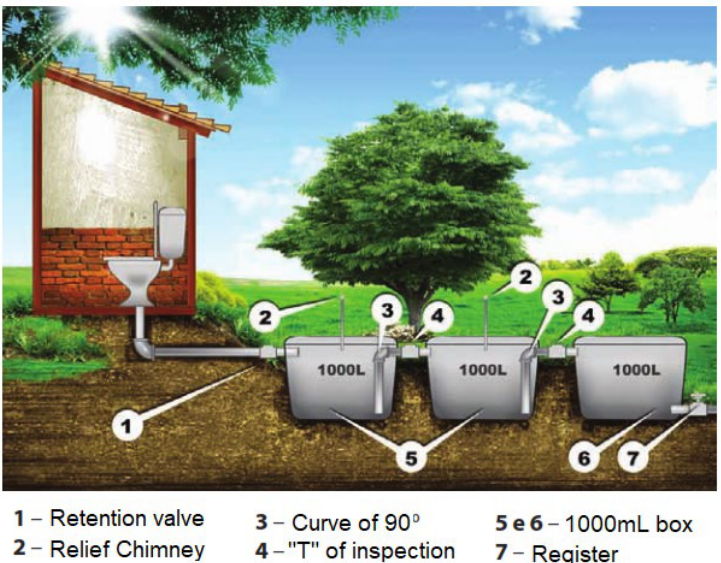
Fig. 1. Structure of the biodigestive septic tank system. Font: Adapted from Novaes,